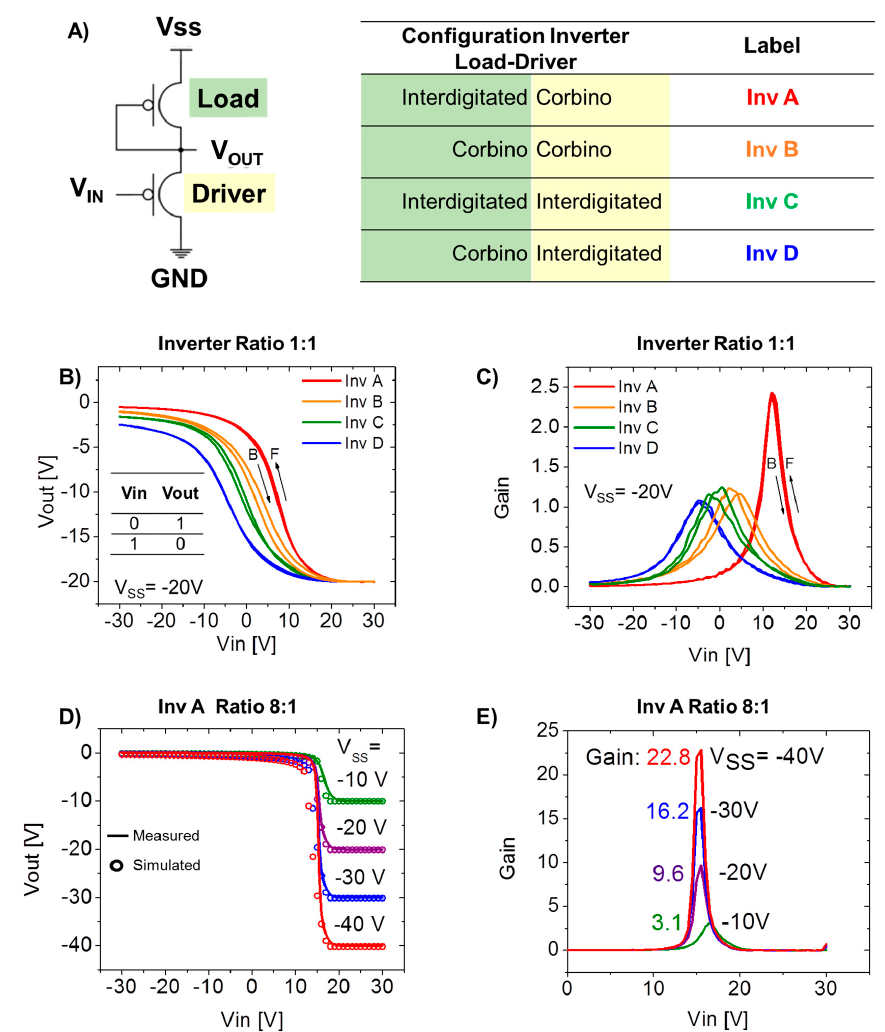
Figure 4. ( A ) Inverter circuits by using different combinations of transistor geometries: ( B ) Voltage transfer characteristics (VTC); ( C ) and gain. ( D ) VTC for Inv A geometry with a ratio 8:1; and ( E ) the respective gain. ”F” and “B” denote forward and backward sweeps, respectively.